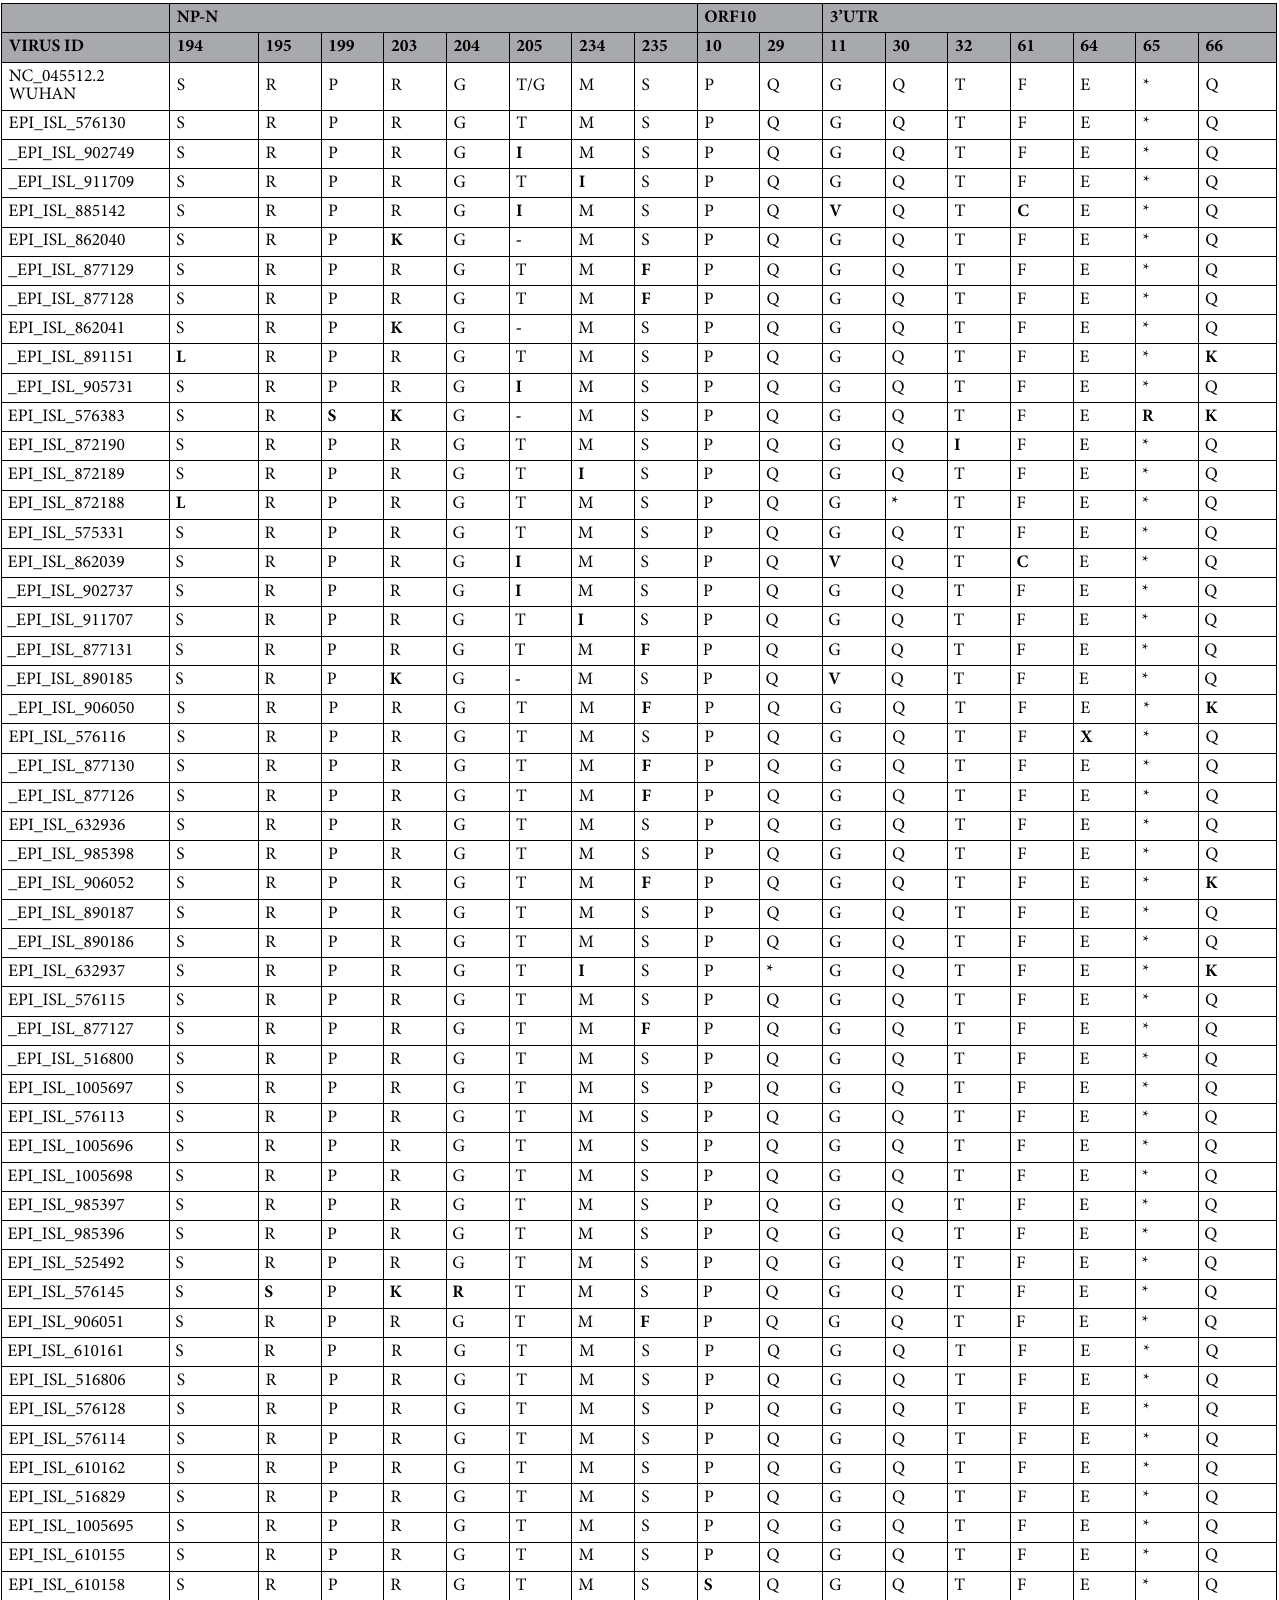
Table 3. Amino acid mutations observed in SARS-CoV-2 genomes collected from patients with COVID-19 in Yogyakarta and Central Java